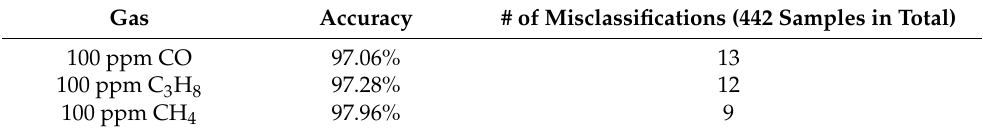
Figure 10. External validation results of CLSTM neural network model using repeated sensor array responses towards ( a ) 100 ppm CO, ( b ) 100 ppm C 3 H 8 and ( c ) 100 ppm CH 4 . Note: solid lines are testing data and dash lines are training data. Table 4. External validation results.